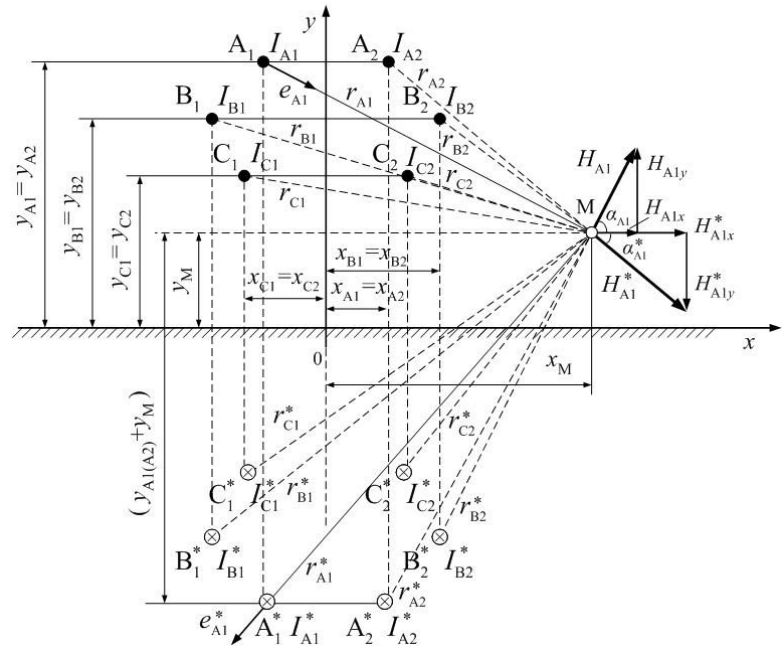
Figure 2. Components of the magnetic field vectors at the point